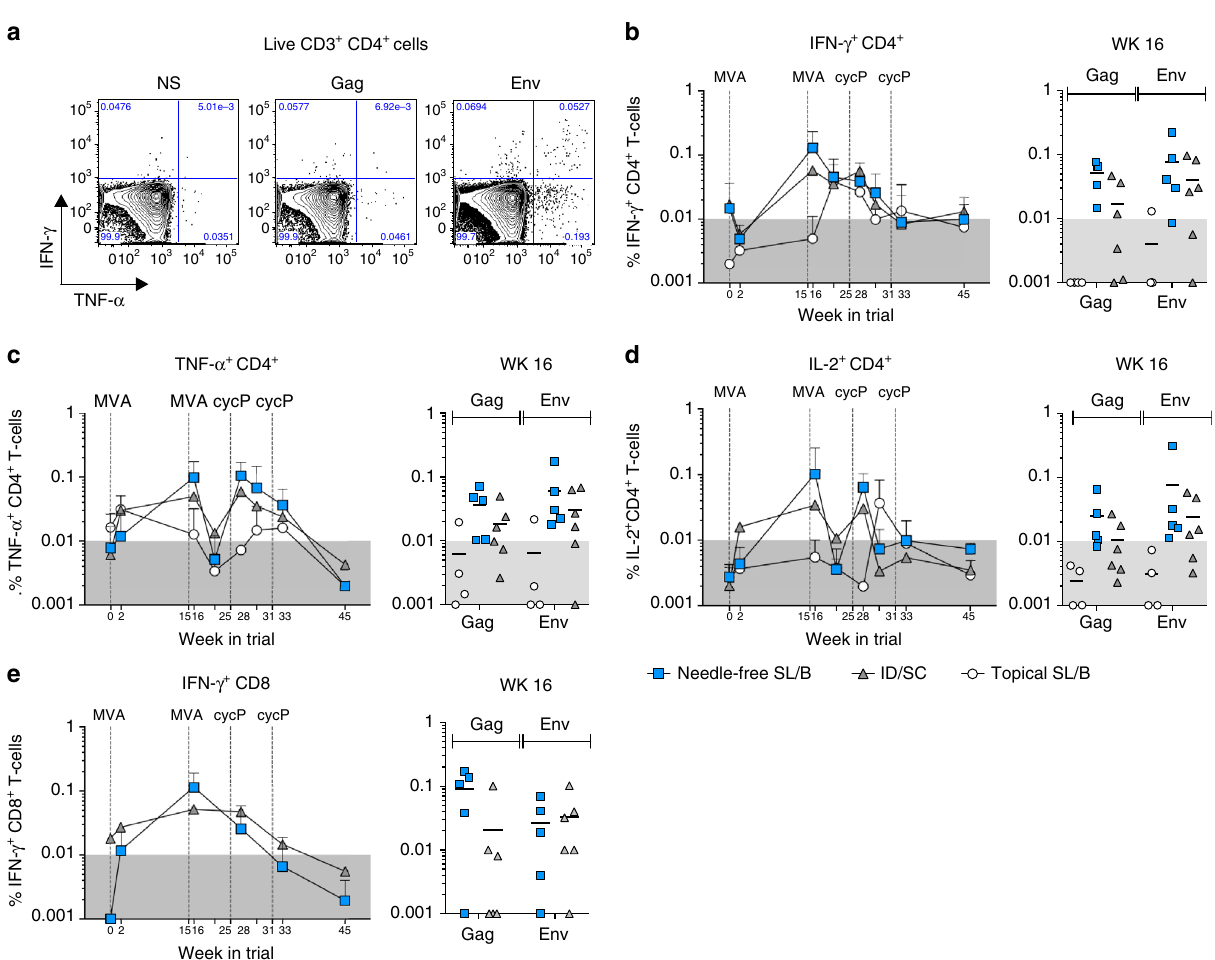
Fig. 5 Needle-free SL/B immunization generates vaccine-speci fi c CD4 and CD8 T cells in the blood. PMBCs were stimulated with HIV-1 consensus B Gag and Env peptides and analyzed by fl ow cytometry for cytokine production. a Representative fl ow plots for IFN- γ and TNF- α cytokine expression on Live CD3 + CD4 + cells in non-stimulated (NS), Gag, or Env stimulated PBMCs is shown. Kinetics of the total (Gag + Env) b IFN- γ , c TNF- α , and d IL-2 response in CD4 + T cells (mean ± S.D.), with the peak response (wk 16) highlighted for each animal (line denotes mean). e Kinetics of the total IFN- γ response in CD8 + cells (mean ± S.D.), with the peak response (wk 16) highlighted for each animal. White circle, topical SL/B ( n = 4); blue square, needle-free SL/B ( n = 5); gray triangle, ID/SC ( n =